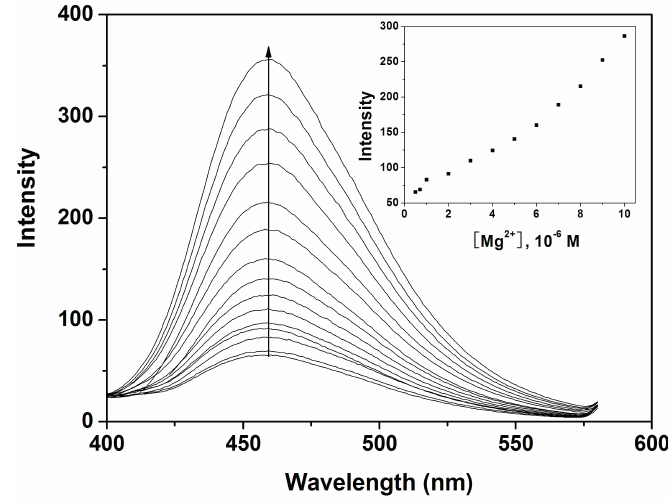
Figure 5. Fluorescence response of P (10 μ M) with various concentrations of Mg 2+ in ethanol-water solution (9:1, v:v, 20 mM HEPES, pH 10.0). Inset: the fluorescence of P (10 μ M) as a function of Mg 2+ concentrations (0.5–12 μ